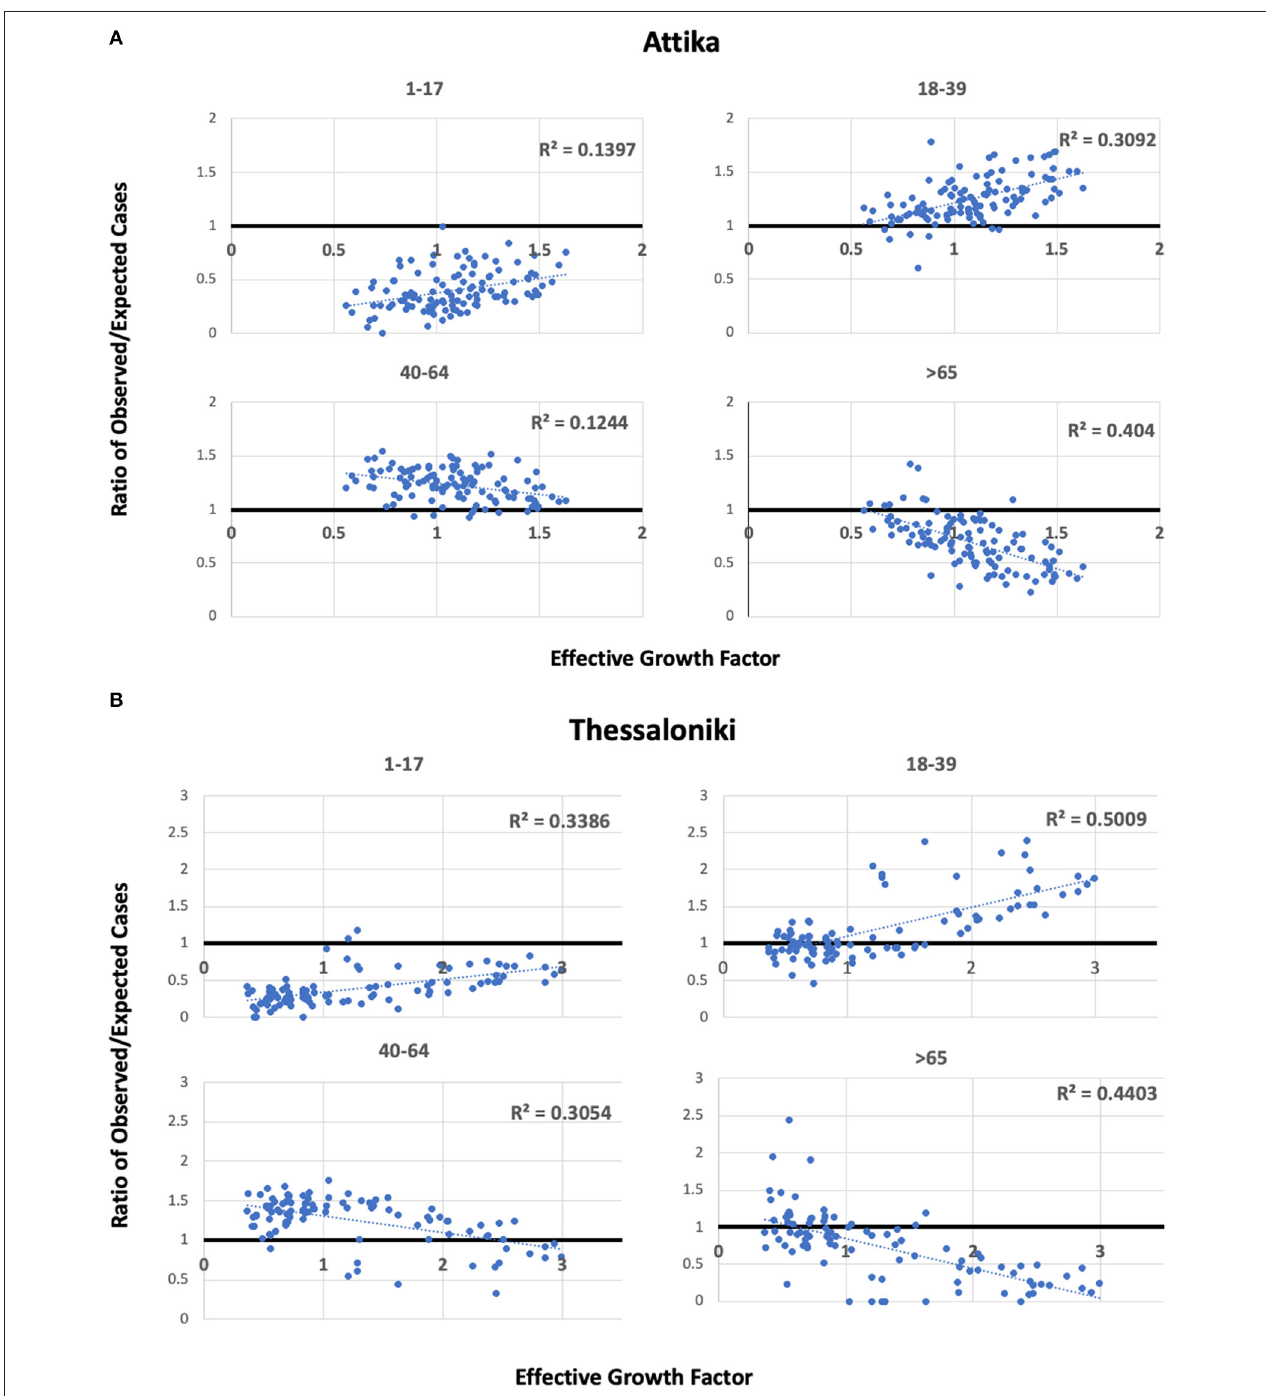
FIGURE 5 | Scatterplots of observed/expected cases per age group and the effective growth factor in Attika (A) and Thessaloniki (B) along linear regression lines and estimated Pearson’s R 2 .